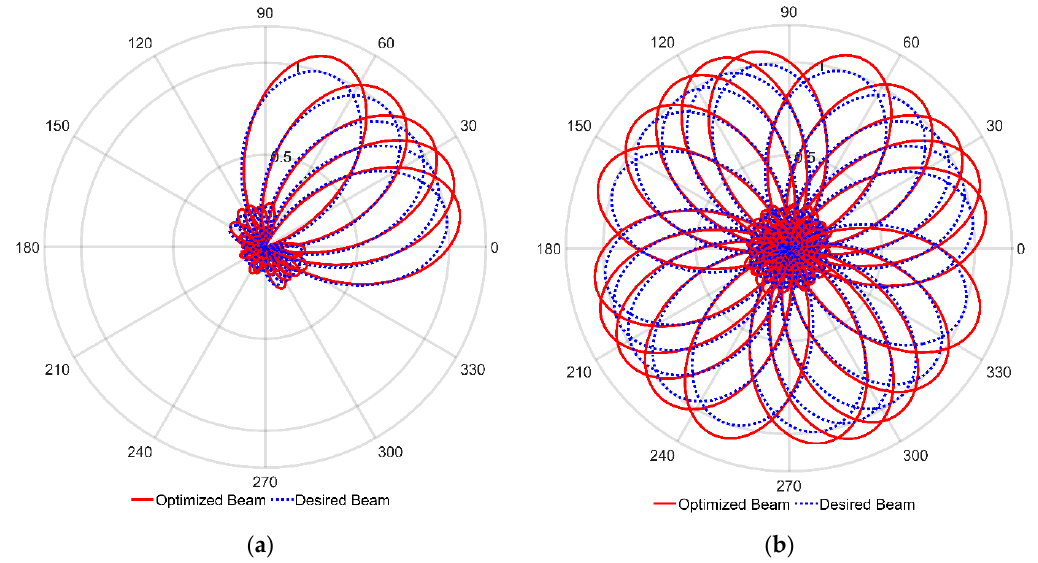
Figure 12. Beam Patterns of Two-Square Configuration 1: ( a ) Beam to random angles 10°, 22.5°, 35°, 50°, and 70°, ( b ) Rotated beams.